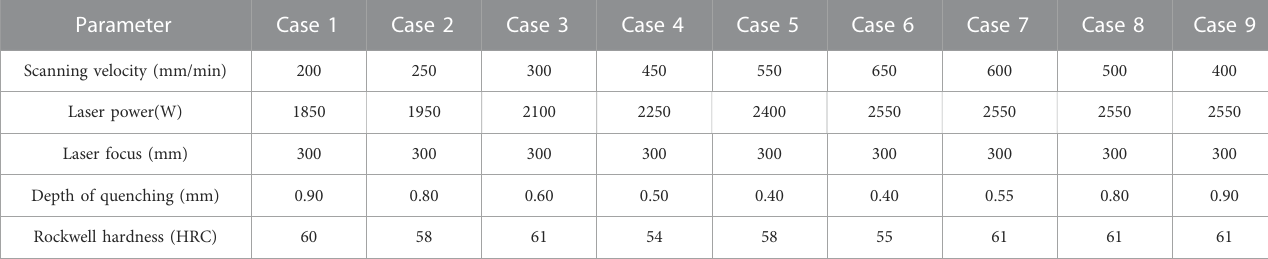
TABLE 1 Results of the laser quenching depth and surface